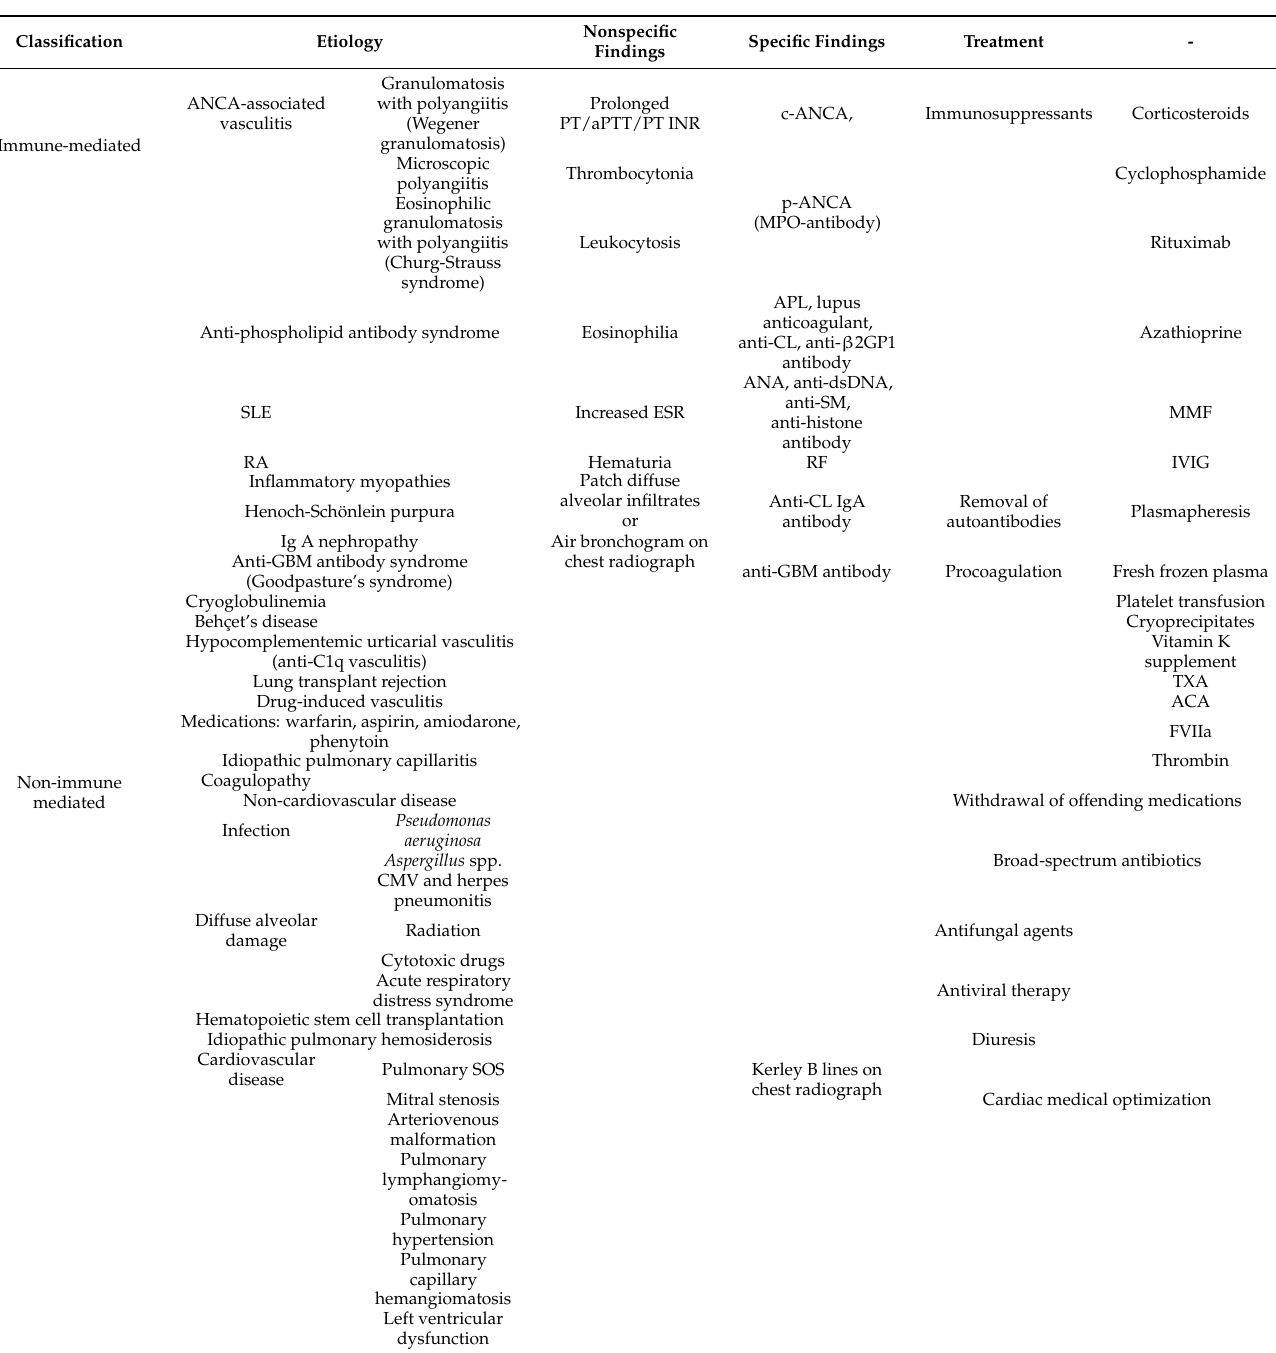
Table 1. Etiologies of diffuse alveolar hemorrhage and treatment